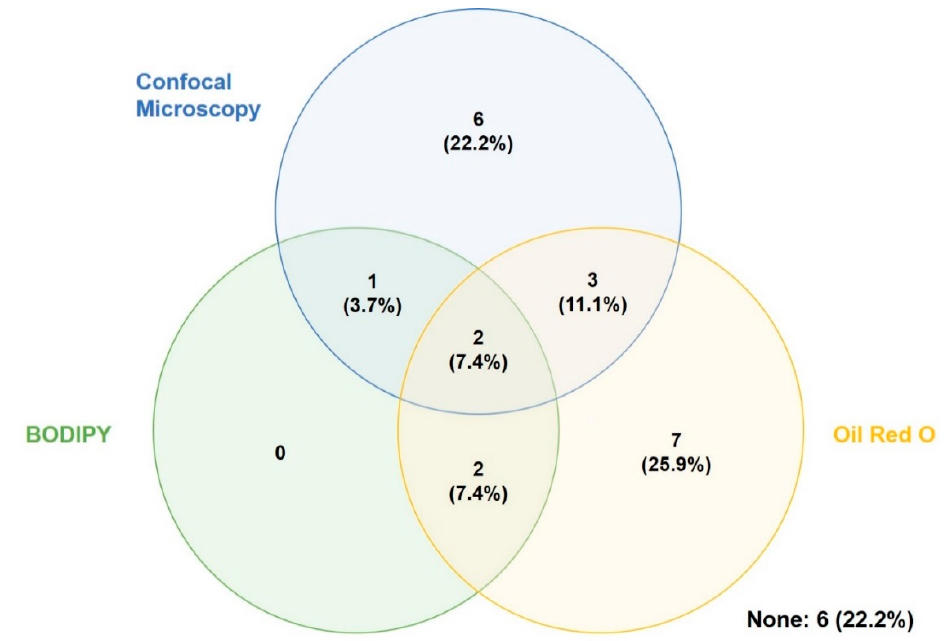
Figure 5. Venn diagram of microscopy techniques used to evaluate hASC in vitro. Results given as a percentage out of the 27 relevant articles.